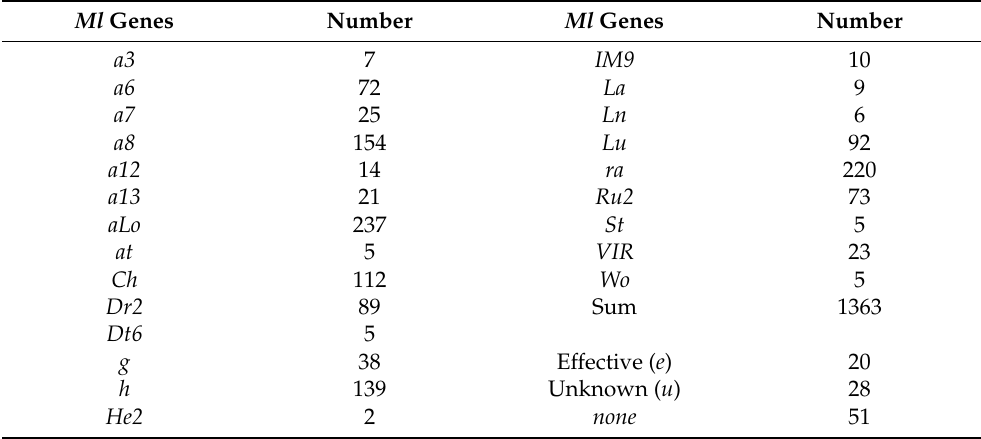
Table 2. Number of specific resistance genes found in 860 single-plant progenies derived from 172 winter barley gene bank accessions. Ml Genes Number Ml Genes Number a3 7 IM9 10 72